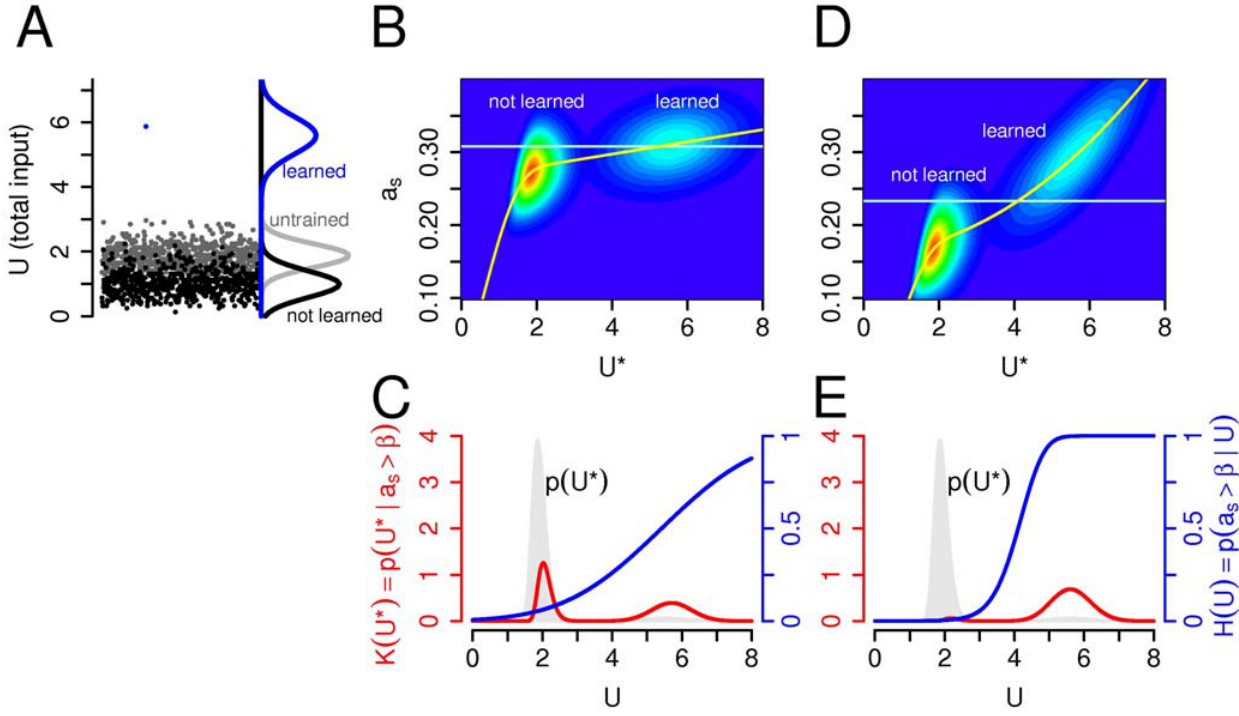
Figure 3. Independent feature detection with Habbian synapses. (A) Synaptic plasticity separates the inputs. Before learning the total synaptic input to a dendritic subunit come from a Gaussian distribution (600 samples are shown with grey circles) with the calculated density function shown on the right (Eq. 5). During the learning process each branch learns its largest input and the response increases to the learned input (blue circle), while it decreases to all other inputs (black circles). The black and blue Gaussian curves show the density functions for the non-learned and learned inputs, respectively (Eq. 19). (B), (D): Color-coded joint distribution of the somatic activation and the maximal dendritic input ( p [ a s , U * ]) in the linear (B) and quadratic (D) case. The horizontal lines indicate the firing threshold. (C), (E): The distribution of the maximal dendritic input when the cell fires ( K ( U * ) in red) and the probability of firing with a given input ( H ( U ) in blue). The distribution of U * is shown in the background. In the linear case, 50% of firing occurs when one of the branches receives its preferred input, while with quadratic integration function more than 95%. Parameters: R =0.01, N